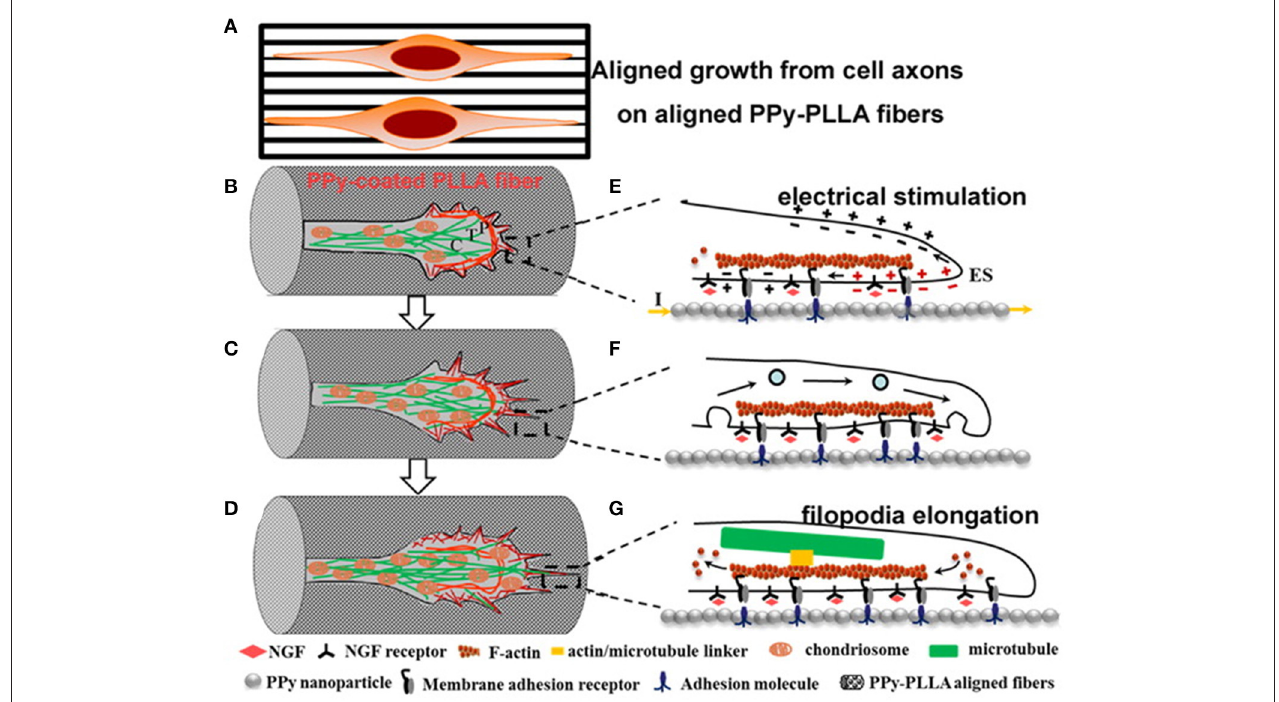
FIGURE 10 | Scheme of axon elongation from PC12 cells on aligned fibres (A) after differentiation, (B–D) change in growth cone, and (E–G) inner change in filopodia during elongation. Reproduced from ( 114) with permission from the publisher.